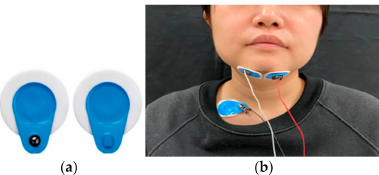
Figure 2. Surface electromyography (sEMG) measurement: ( a ) bipolar electrodes, ( b ) attachment of the sEMG